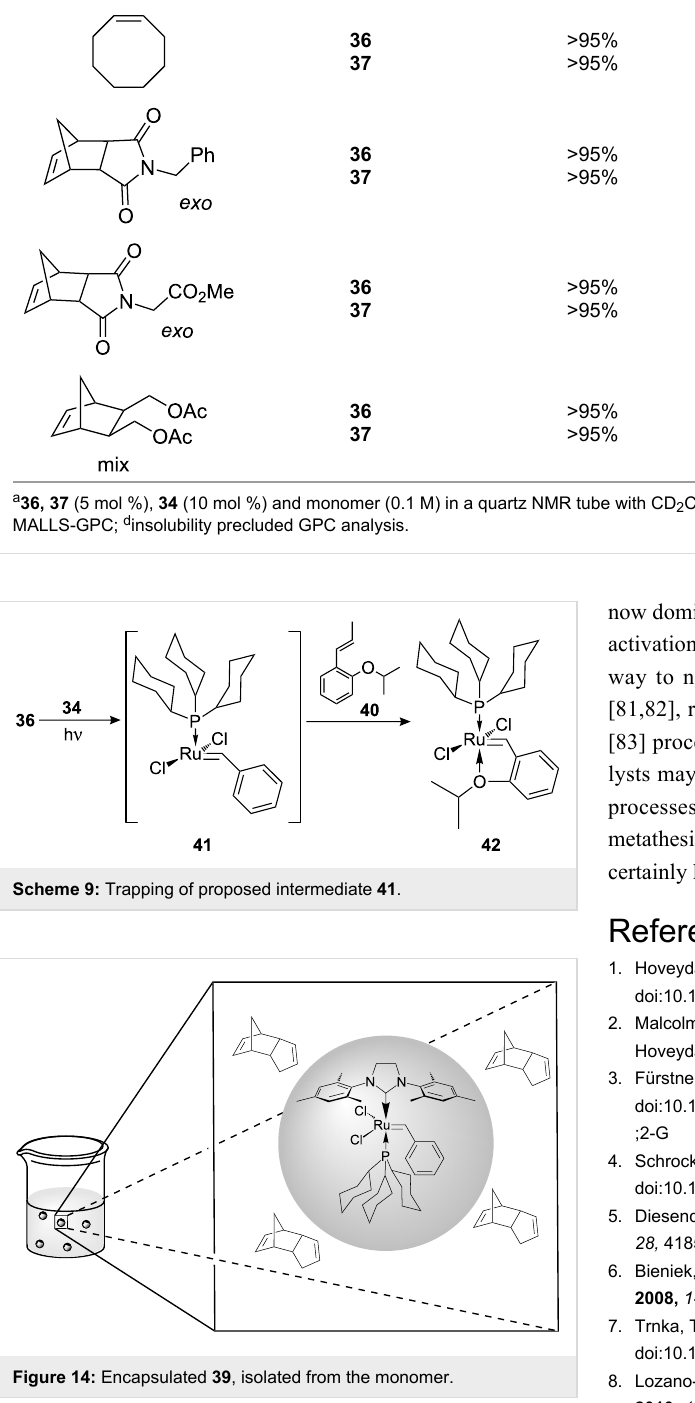
Table 7: ROMP by PAG and precatalysts 36 and 37 a . Monomer